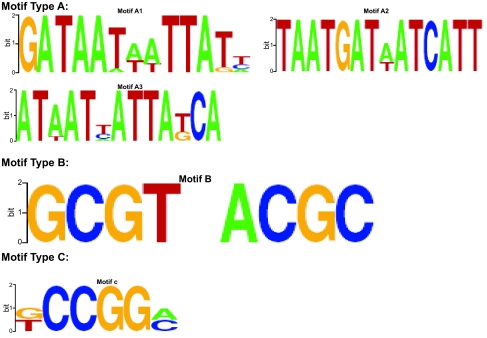
The LOGO graphical representation (Schneider and Stephens 1990) of predicted motif candidates in the iron regulated gene cluster. The images were generated using WebLogo (Crooks GE 2002) using the overlapping aligned patterns from the MITRA analysis and DFDR prediction.. The relative height of the base reflects the degree of conservation.